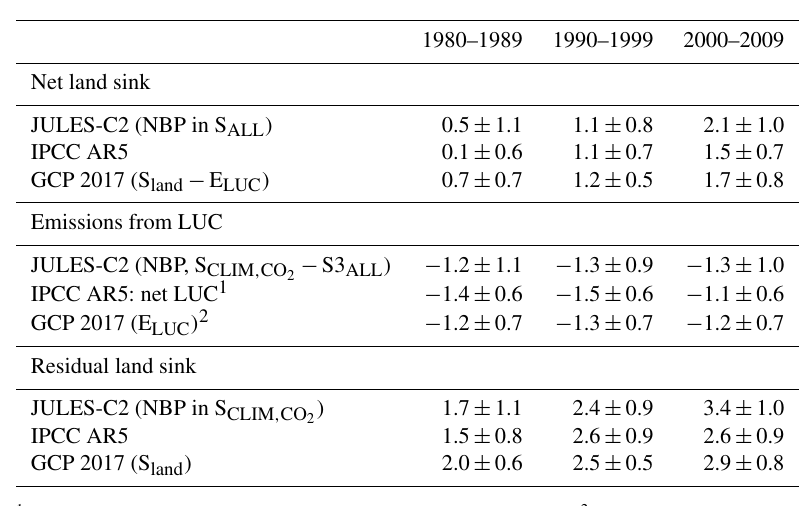
Table 6. Estimates of net land sink, emissions due to land use change, and the “residual” sink on land from JULES compared to two other methods. Uncertainty ranges were reported differently for each method: for JULES ± 1 σ indicates the interannual variability of the annual mean, the IPCC reported a 90% confidence interval (based on GCP 2013) which here is converted to ± 1 σ , and GCP reported ± 1 σ of the